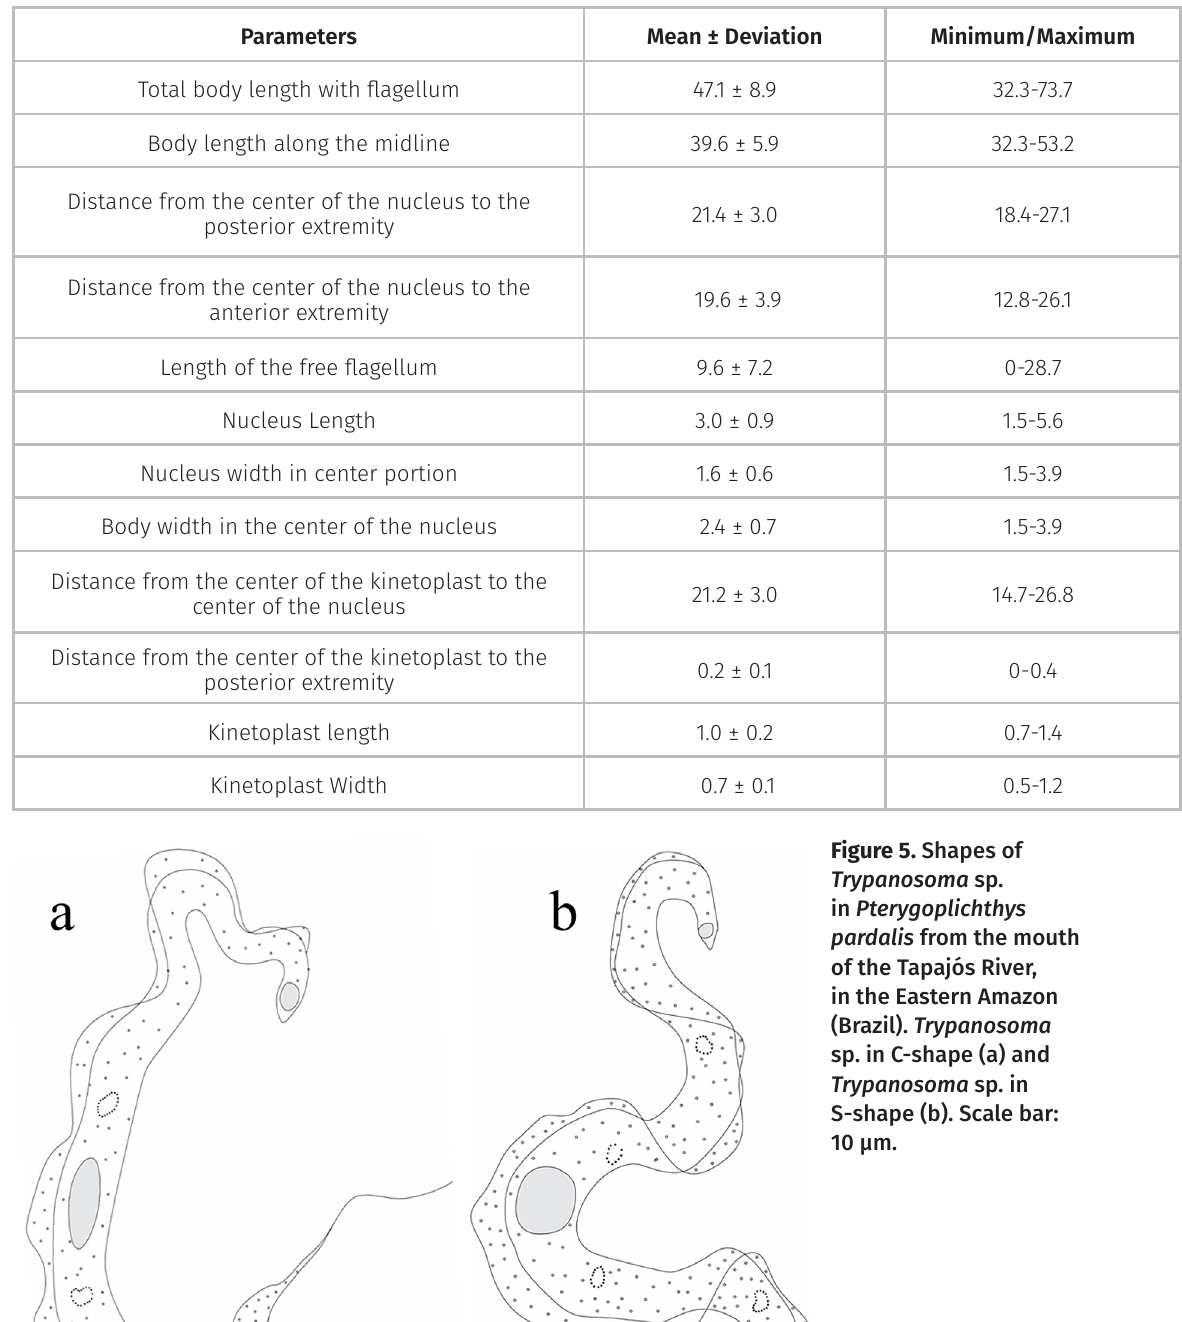
Figure 5. Shapes of Trypanosoma